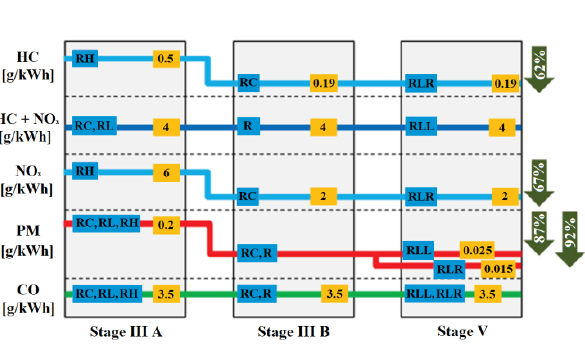
Fig. 3. Exhaust emission limits for Stages IIIA, IIIB and V